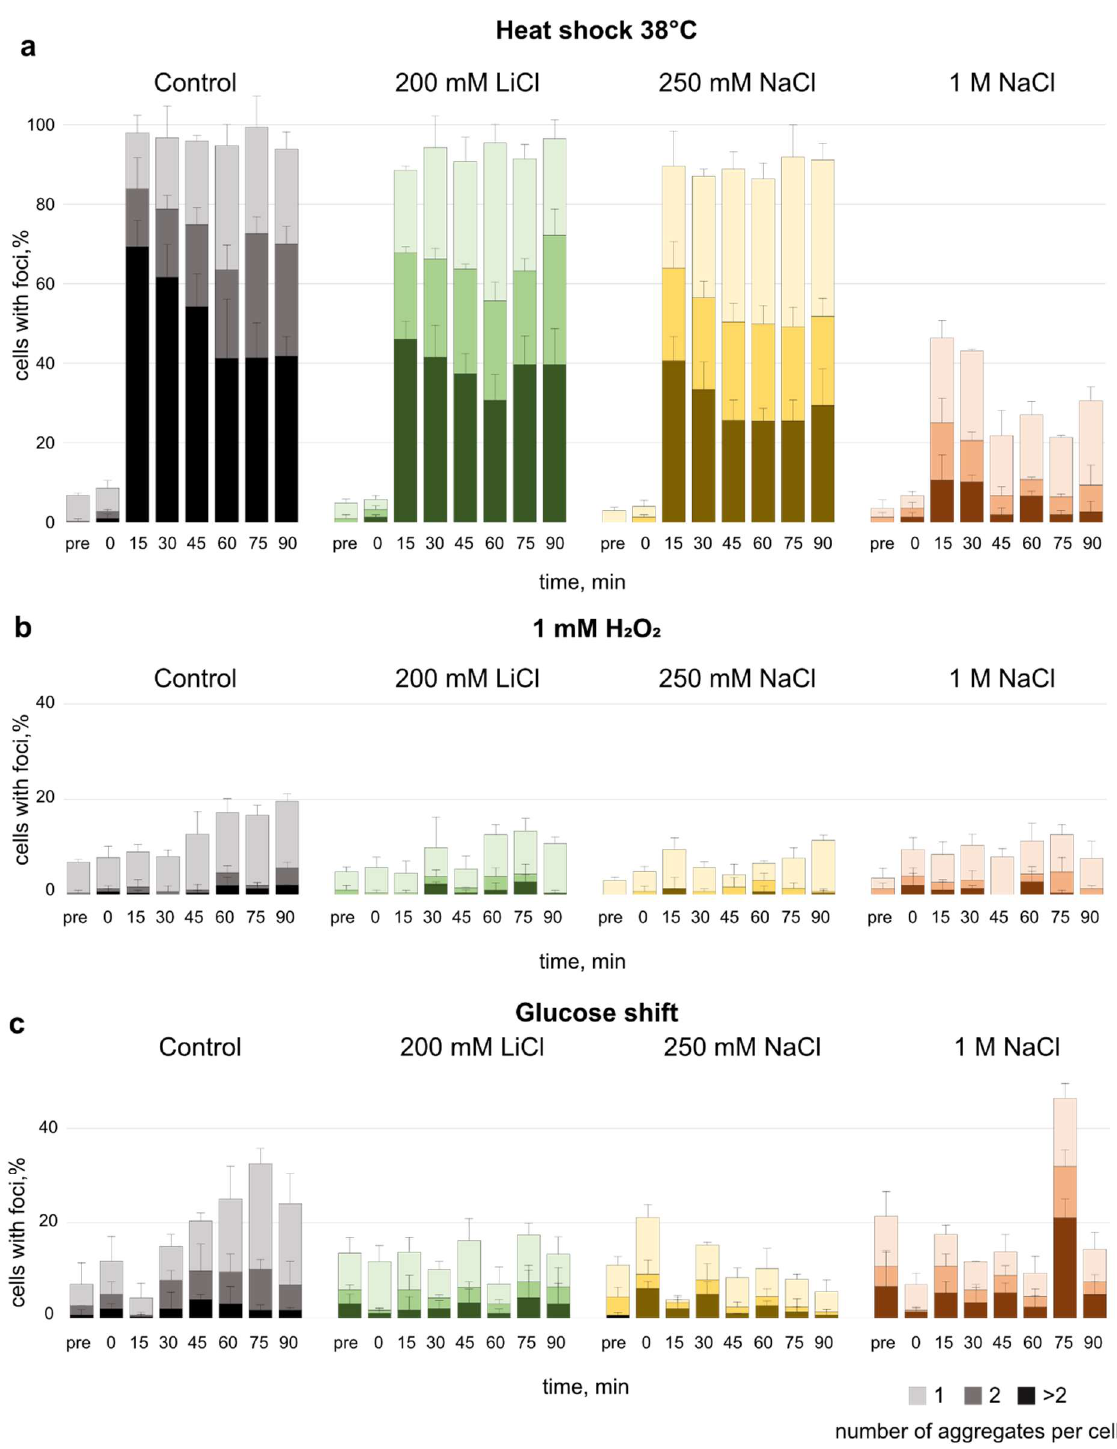
Figure 3. Percentage of cells with Hsp104-GFP foci after two hours of pre-adaptation to salt, followed by the exposure to ( a ) heat shock, ( b ) hydrogen peroxide, or ( c ) shift to low glucose SDM (0.05% glucose ( w/v )). Cells were fixed in 3.7% ( v/v ) formaldehyde for imaging. Colour shades represent the number of aggregates per cell, error bars indicate SD.